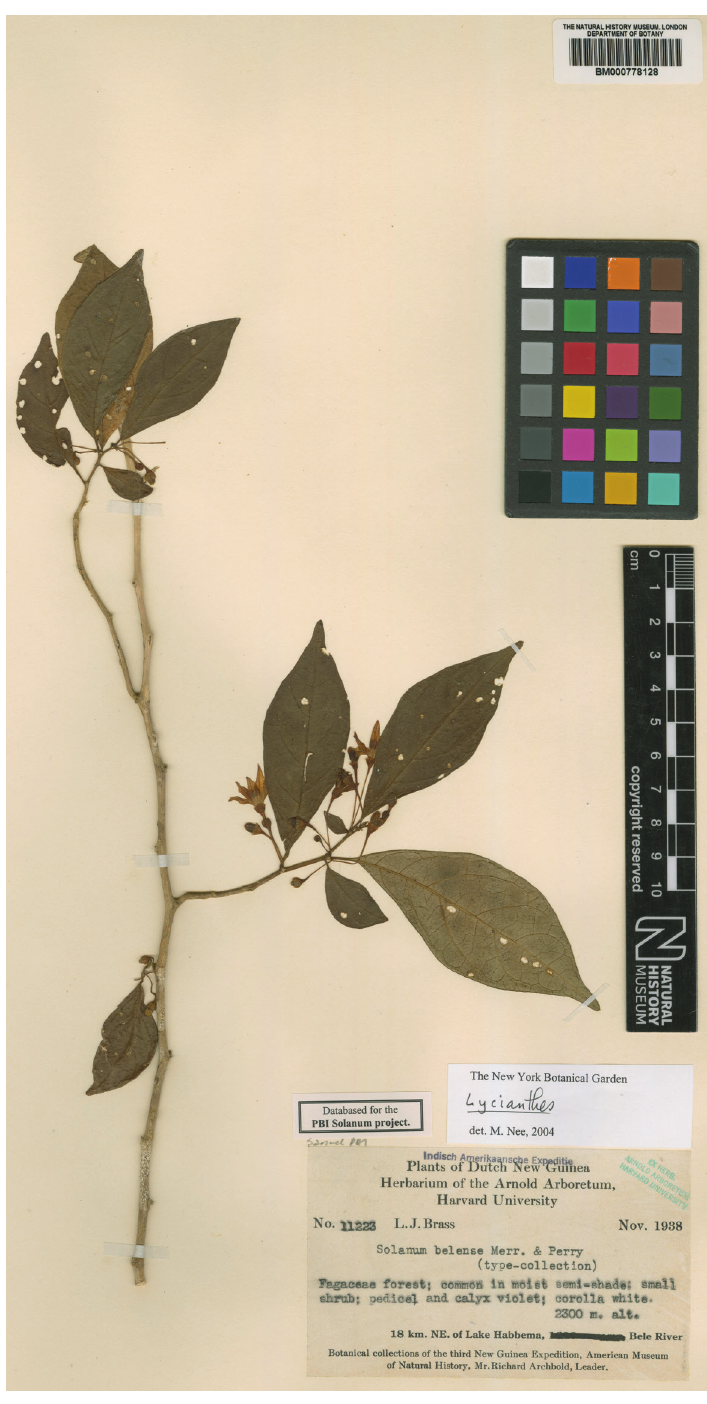
Figure 8. Lycianthes belensis herbarium specimen. Indonesia. Papua: Brass 11223 (isotype of S. belense , BM000778128). Courtesy of the Trustees of the Natural History Museum, London, reproduced with